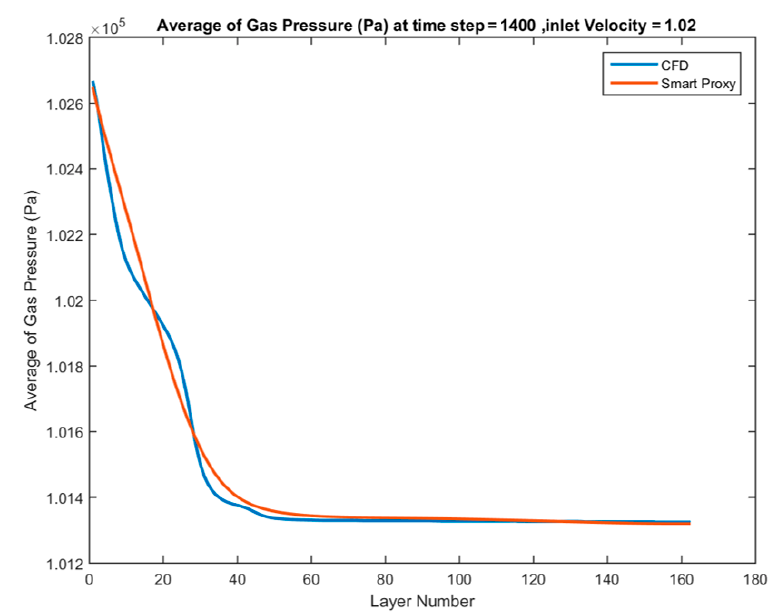
Figure 42. Spatially averaged CFD and smart proxy results for gas pressure (Pa) at time step = 1400 for blind test condition of V in = 0.72 m/s.